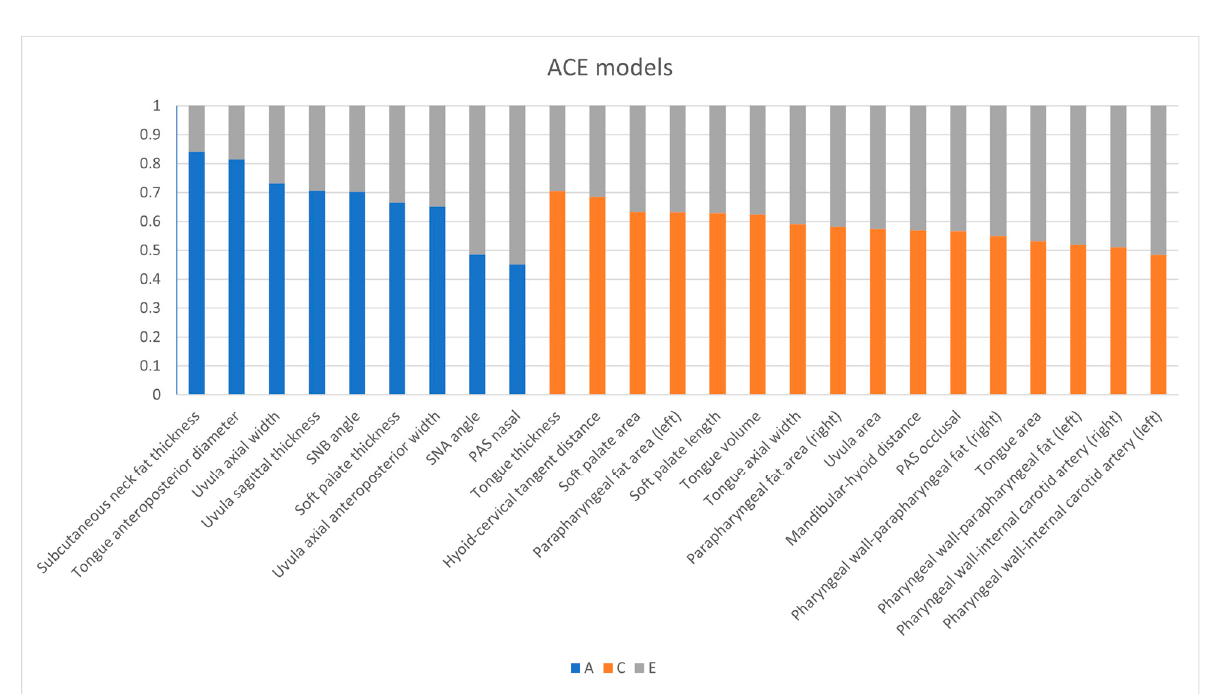
Figure 7. A bar-chart demonstration of the ACE model distributions from the highest A values (blue) to the highest E values (grey). Orange demonstrates C values in a decreasing order.